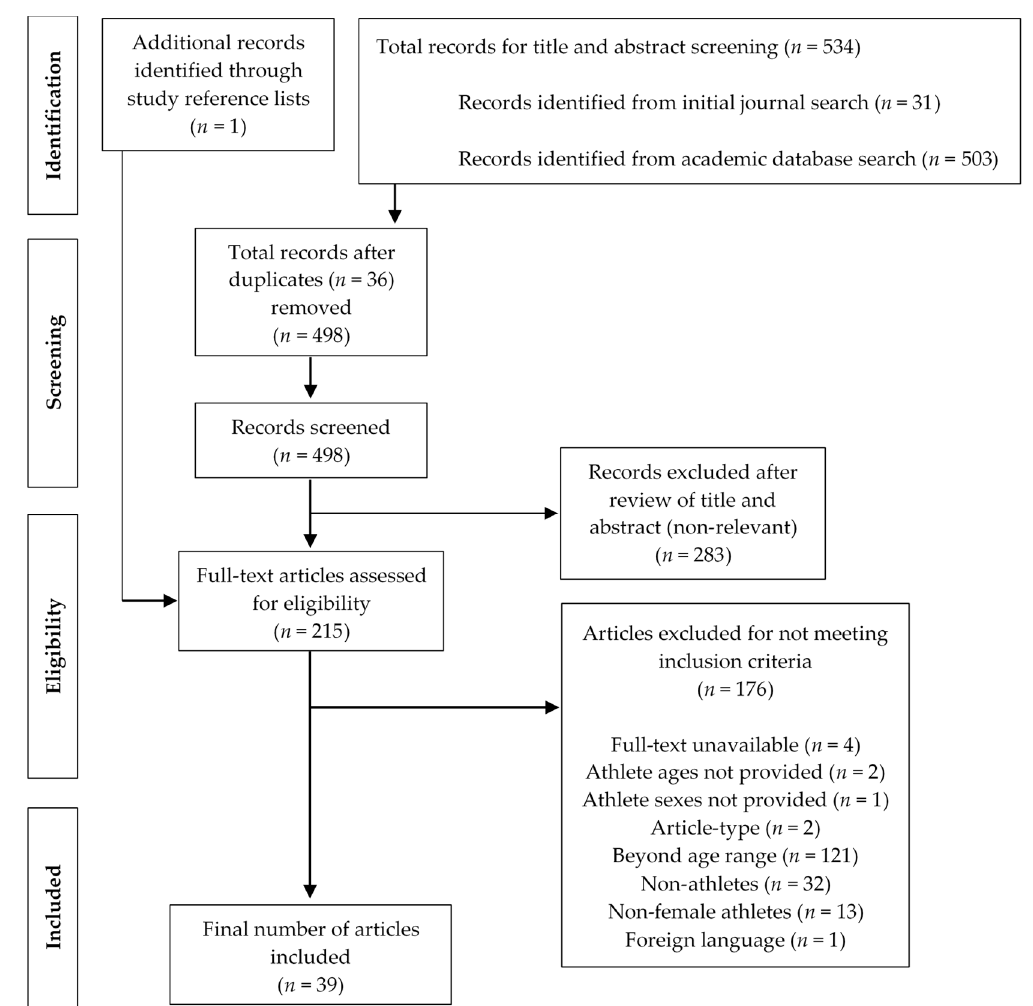
Figure 1. Flowchart of study selection.